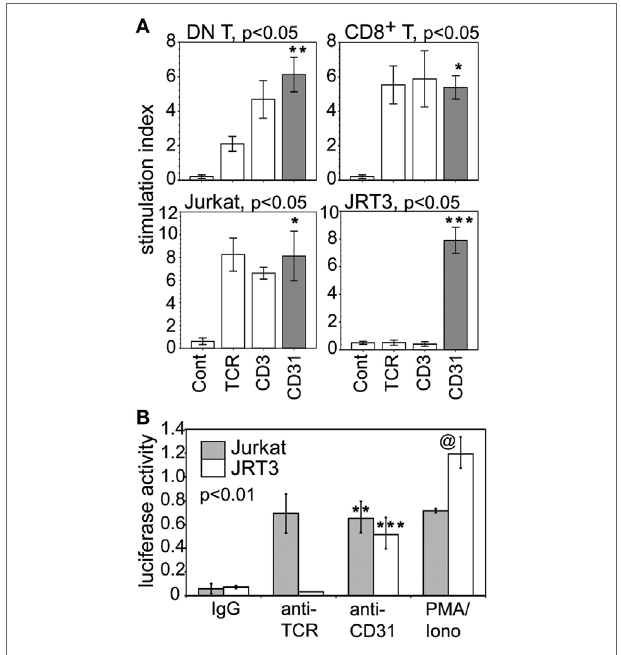
FigUre 6 | CD31-driven expression of ROR γ T and trans -activation of IL-17A gene promoter. (a) Data shown (bar means, SD whiskers; n = 5–7 per group) are ROR γ T levels in synovial CD31 + CD28 null DN and CD8 + αβ T cells, Jurkat, and JRT3 following CD31, TCR, CD3, or IgG stimulation. Crosslinking assays were performed as in Figure 3a . Data normalization done as in Figures 3B and 4 . The indicated P -values were determined by Kruskal–Wallis ANOVA. Post hoc group comparisons by Tukey: *** P < 0.001 indicates CD31 crosslinking in JRT3 were significantly different from TCR and CD3 crosslinking, and the IgG control; ** P < 0.05 indicates CD31 crosslinking on DN T cells were significantly different from TCR or CD3 crosslinking, or IgG control; * indicates crosslinking of CD31, TCR, or CD3 on CD8 T cells and Jurkat were not significantly different but were significantly different ( P < 0.001) from the IgG control. (B) Data shown (mean bars, SD whiskers; n = 4–7 per group) are IL-17A gene promoter- driven luciferase reporter activities of Jurkat and JRT3. The data were normalized for transfection efficiency by co-transfection of Renilla luciferase plasmid. Receptor crosslinking was performed as in Figure 3a . The indicated P -value was determined by Kruskal–Wallis ANOVA. Post hoc group comparisons by Tukey: [**] indicates crosslinking of CD31 and TCR on Jurkat was not significantly different, but either one was significantly different ( P < 0.005) than the IgG control; [***] P < 0.001 indicates CD31crosslinking on JRT3 cells were significantly different than TCR crosslinking or the IgG control; [@] P < 0.005 indicates control luciferase activity of phorbol myristyl acetate/Iono-stimulated JRT3 without receptor crosslinking was higher than